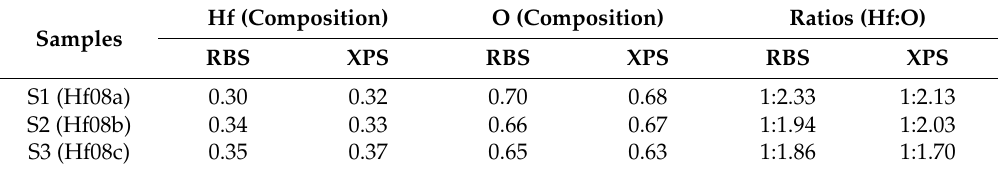
Table 3. The compositions of the three HfO 2 films on Si obtained by RBS and XPS.